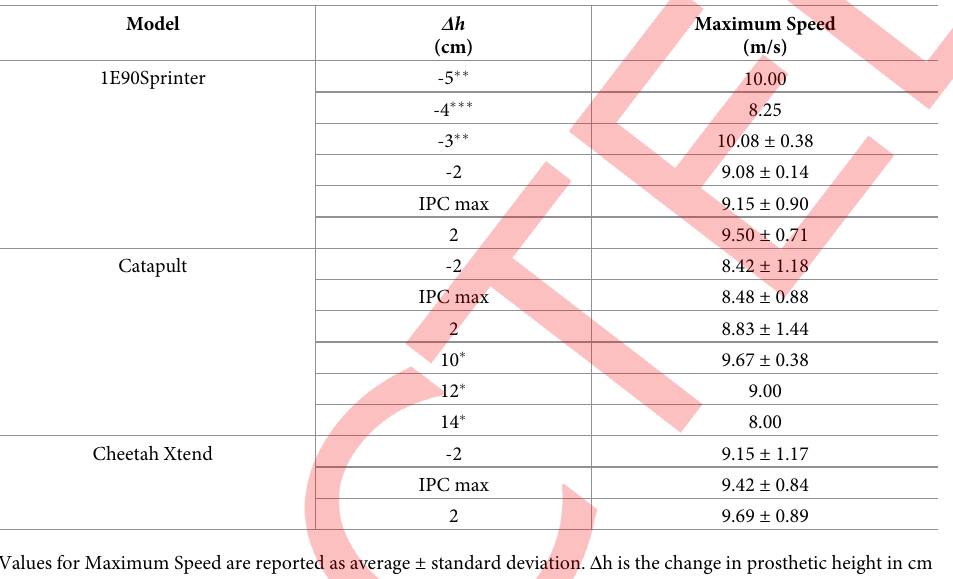
Appendix Table 2. Maximum speeds resulting from each RSP model for different: Stiffness categories prosthetic heights.